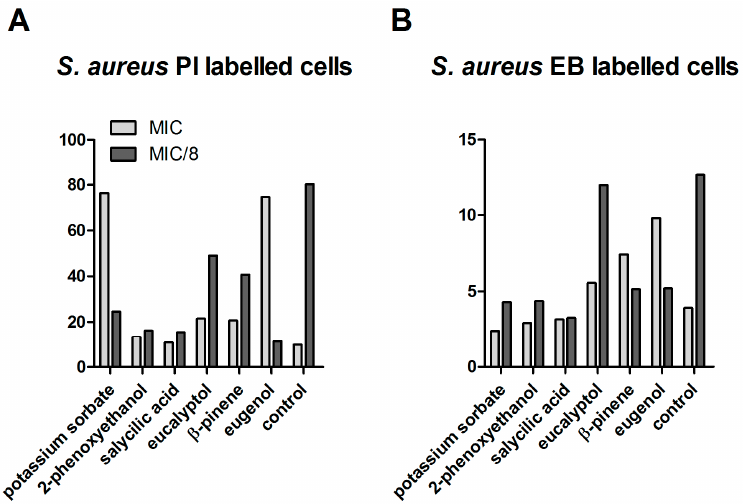
Figure 2. Median of fluorescence intensity (MFI) for the analytical variants tested on S. aureus strainATCC 6538. ( A ) MFI for S. aureus propidium iodide (PI)-labeled cells; ( B ) MFI for S. aureus ethidium bromide (EB)-labeled cells.